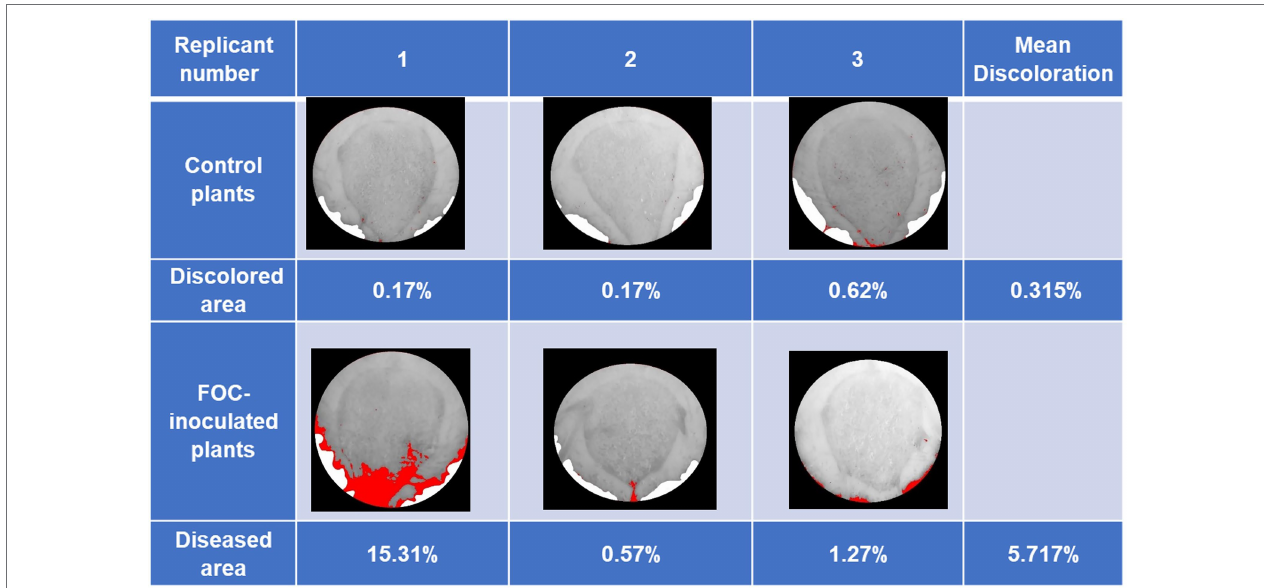
FIGURE 1 | Banana Fusarium symptom development in pseudostem cross-sections during the first trial at 89 days after inoculation (DAI). Pure white areas are cover for areas in the image that are not part of the pseudostem. Percentage of diseased areas (denoted by large continuous red areas in the images) was measured in FOC-inoculated plants using ImageJ.JS software, showing discoloration caused by disease infection. Red areas were shown in the Control group due to shadow, soil particulate, and other factors darkening parts of the images because ImageJ.JS software only distinguishes color by pixel. The Drought group plants were not harvested for pseudostem examination in this trial.